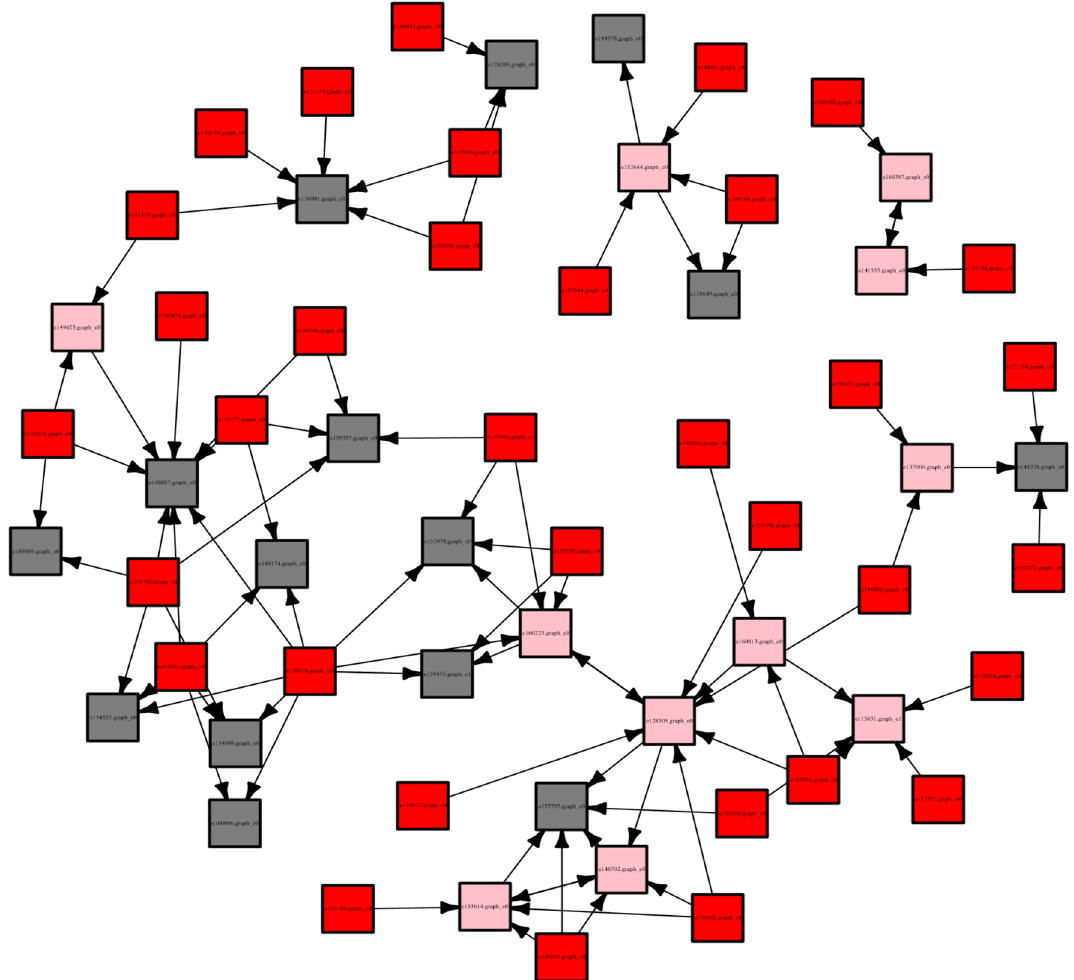
Figure 6. Gene regulatory network diagram (Pink represents the genes within the five pathways, red represents the genes outside the five pathways, and grey represents the functional proteins).